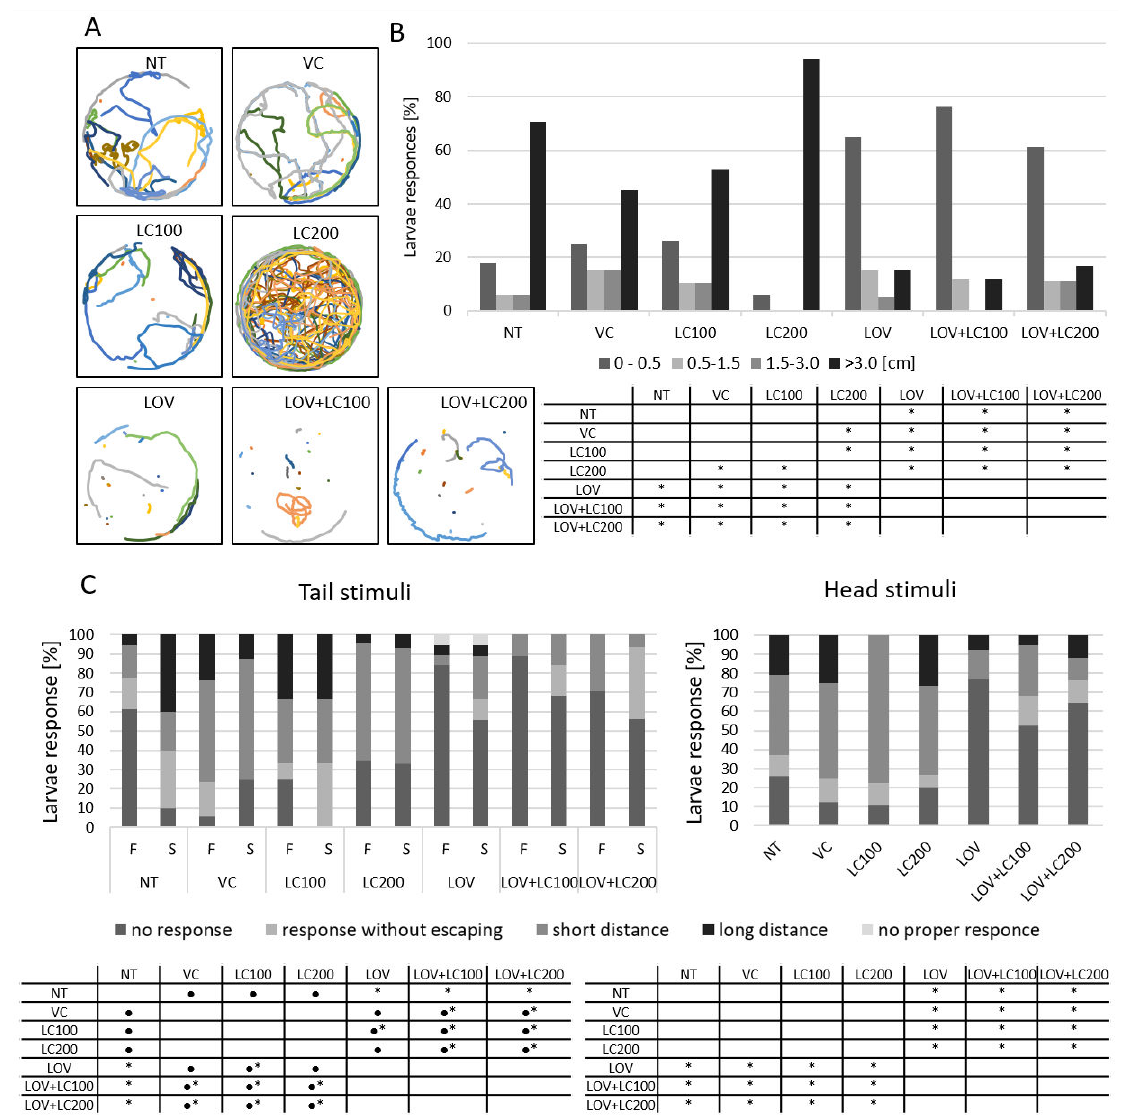
Figure 4. Swimming behaviour of 120 hpf zebrafish larvae exposed to lovastatin (LOV) and L-carnitine (LOV+LC200) treatment. ( A ) Spontaneous displacement of zebrafish larvae in control (non-treated, NT; vehicle control, VC; 100 µ M L-carnitine, LC100; 200 µ M L-carnitine, LC200)